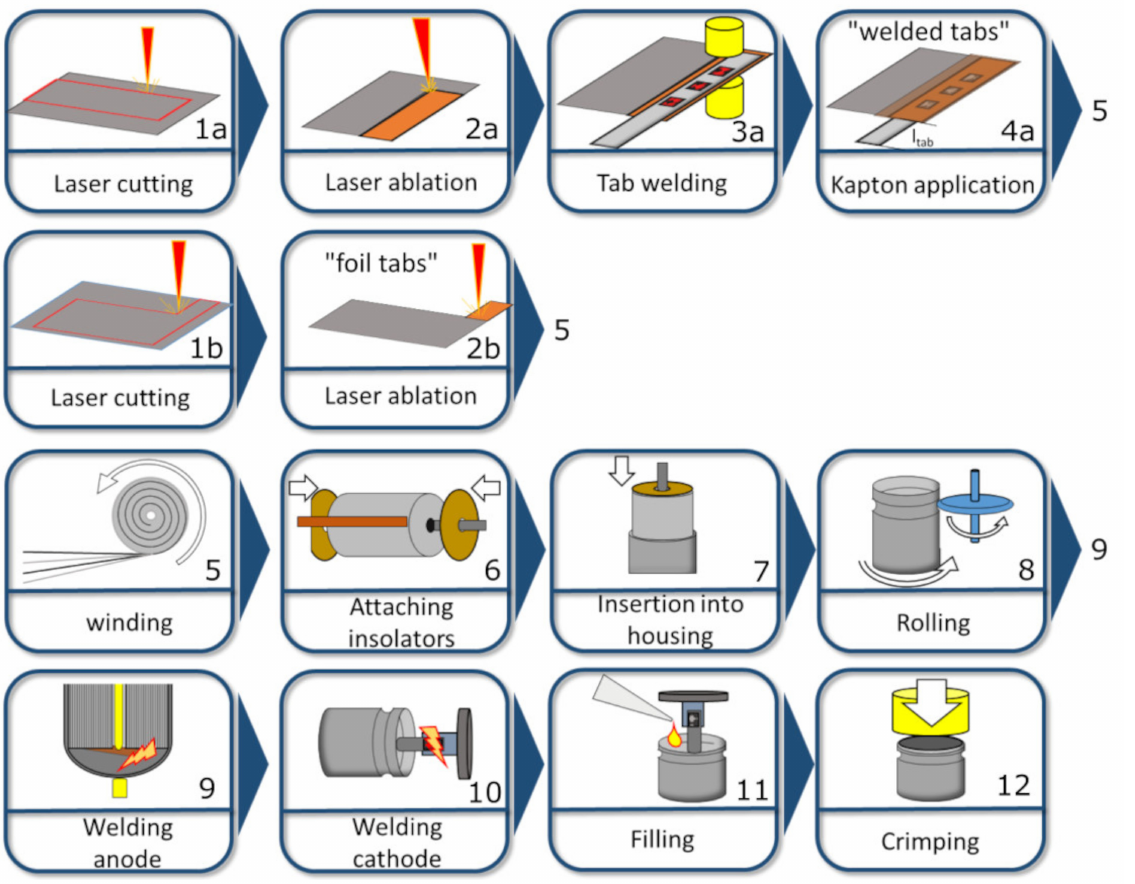
Figure 2. Processes in the production of 21700 cells on pilot-scale showing differences in the process steps leading to welded tabs ( 1a – 4a ) and foil tabs ( 1b – 2b ) and general steps ( 5 – 12